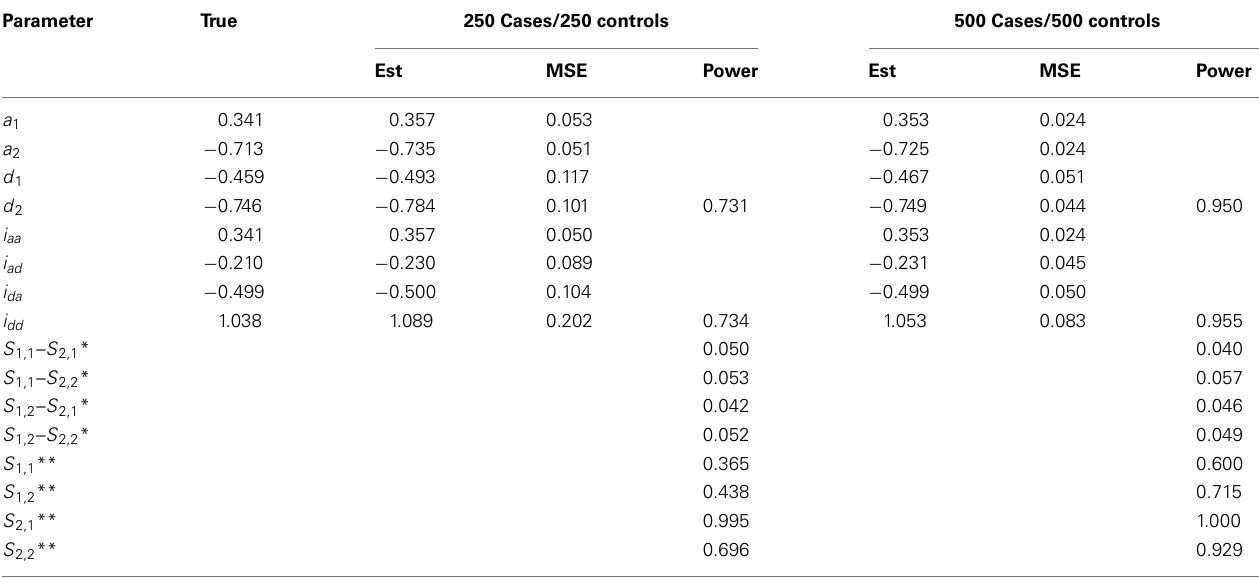
TableA4 | Estimation of genetic parameters and power of epistatic detection from a simulated data for two independent blocks under Scenario 2 for all 1000